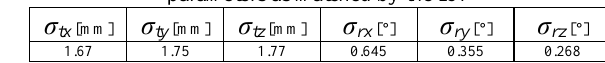
Table 7: Standard deviations for the